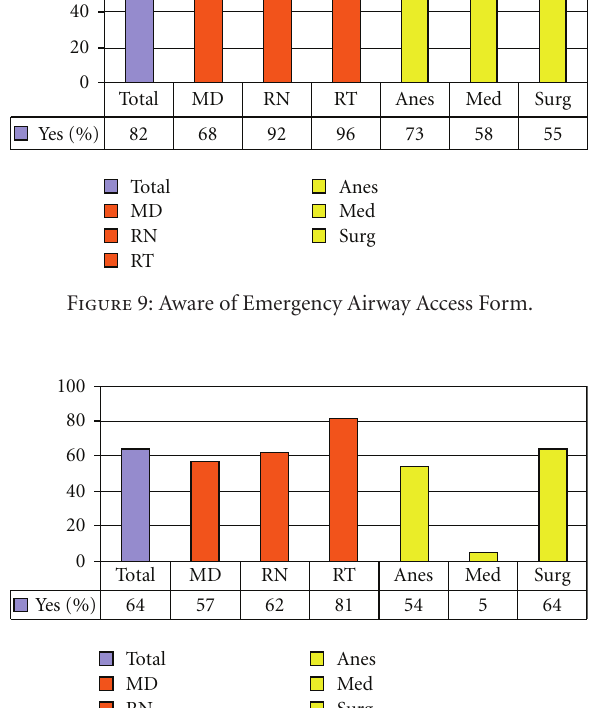
Figure 8: Stay sutures allow easier reinsertion of tracheotomy tube (% Correct).